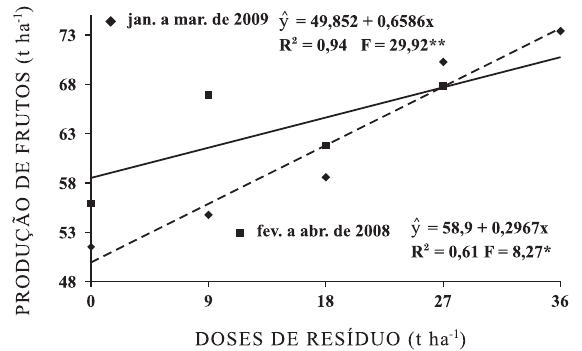
Figura 1. Efeitos de doses do resíduo da indústria processadora de goiabas sobre a produtividade de frutos, em pomar de goiabeiras cultivar Paluma (colheita de fevereiro a abril de 2008 e janeiro a março de 2009); **, *: significativo a 1 e 5 %, respectivamente.